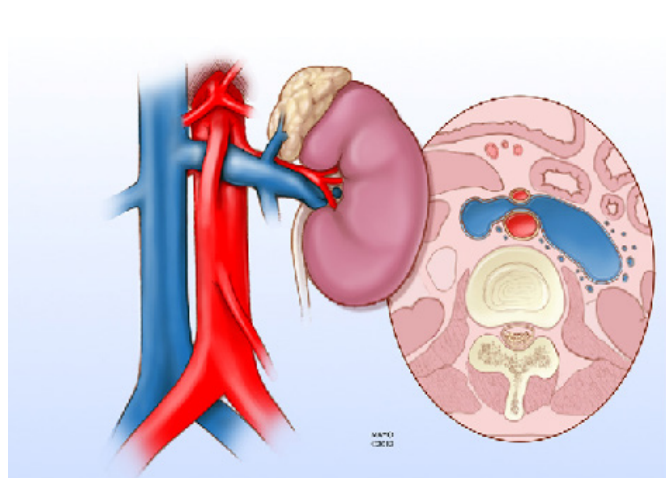
Figure 1. Illustration showing the anterior nutcracker syndrome in which the left renal vein is compressed as it passes between the aorta and the superior mesenteric artery resulting in dilation of the portion proximal to the kidney hilum. Reproduced from open access reference